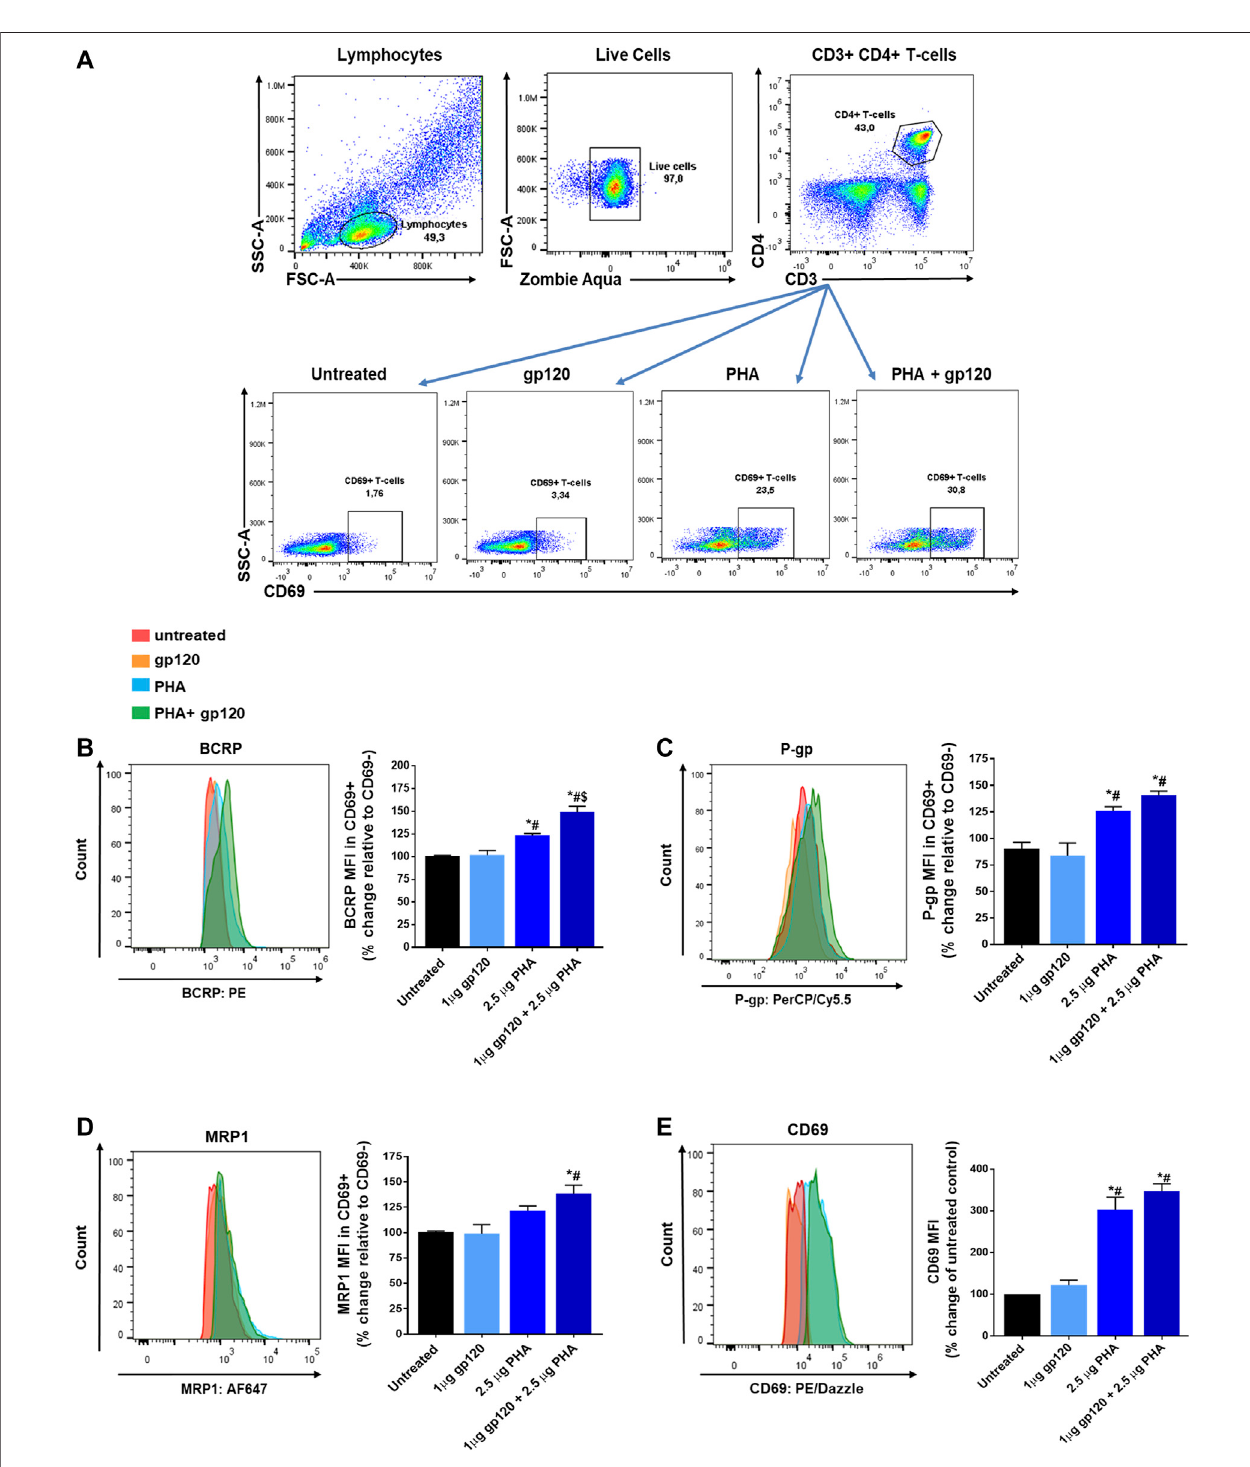
FIGURE1| ExpressionofBCRP,P-gp,MRP1andCD69inPHAand/orgp120activatedCD4+T-cells. (A) RepresentativegatingstrategyforCD4 + T-cellsisolated from PBMCs; panels from left to right show lymphocytes selected based on light scattering properties, viable (negative for Zombie Aqua) single cells were then selected for CD3 + CD4 + expression, CD69 expression was determined in untreated, gp120 treated, PHA treated, or gp120 + PHA treated CD4 + T-cells. (B – D) Mean percent change ± SEM of the expression (median fl uorescence intensity, MFI) of each ABC transporter in CD4 + CD69 + T-cells relative to their expression in non-activated CD4 + CD69 − T-cells. (E) Mean percent change ± SEM in the expression of CD69 in gp120 and/or PHA treated cells compared to untreated cells. Left panels show representative histograms corresponding to bar charts on the right (B – E) . Statistical analyses were performed using one-way ANOVA with Bonferroni ’ s multiple comparisons test, p < 0.05. * , statistically signi fi cant difference compared to untreated control cells; # , statistically signi fi cant difference compared to cells treated with gp120 only; $ , statistically signi fi cant difference compared to cells treated with PHA only, n (cid:2) 3 donors.